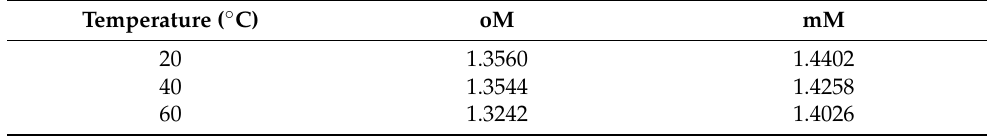
Table 2. Variations of the measured values of slope M of the p (cid:48) – q diagrams at